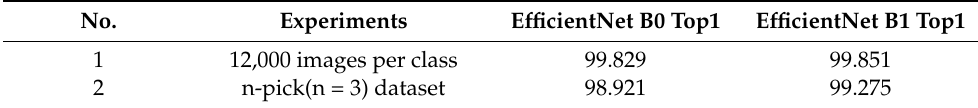
Table 8. Average calculation rate for EfficientNet experiments (s).